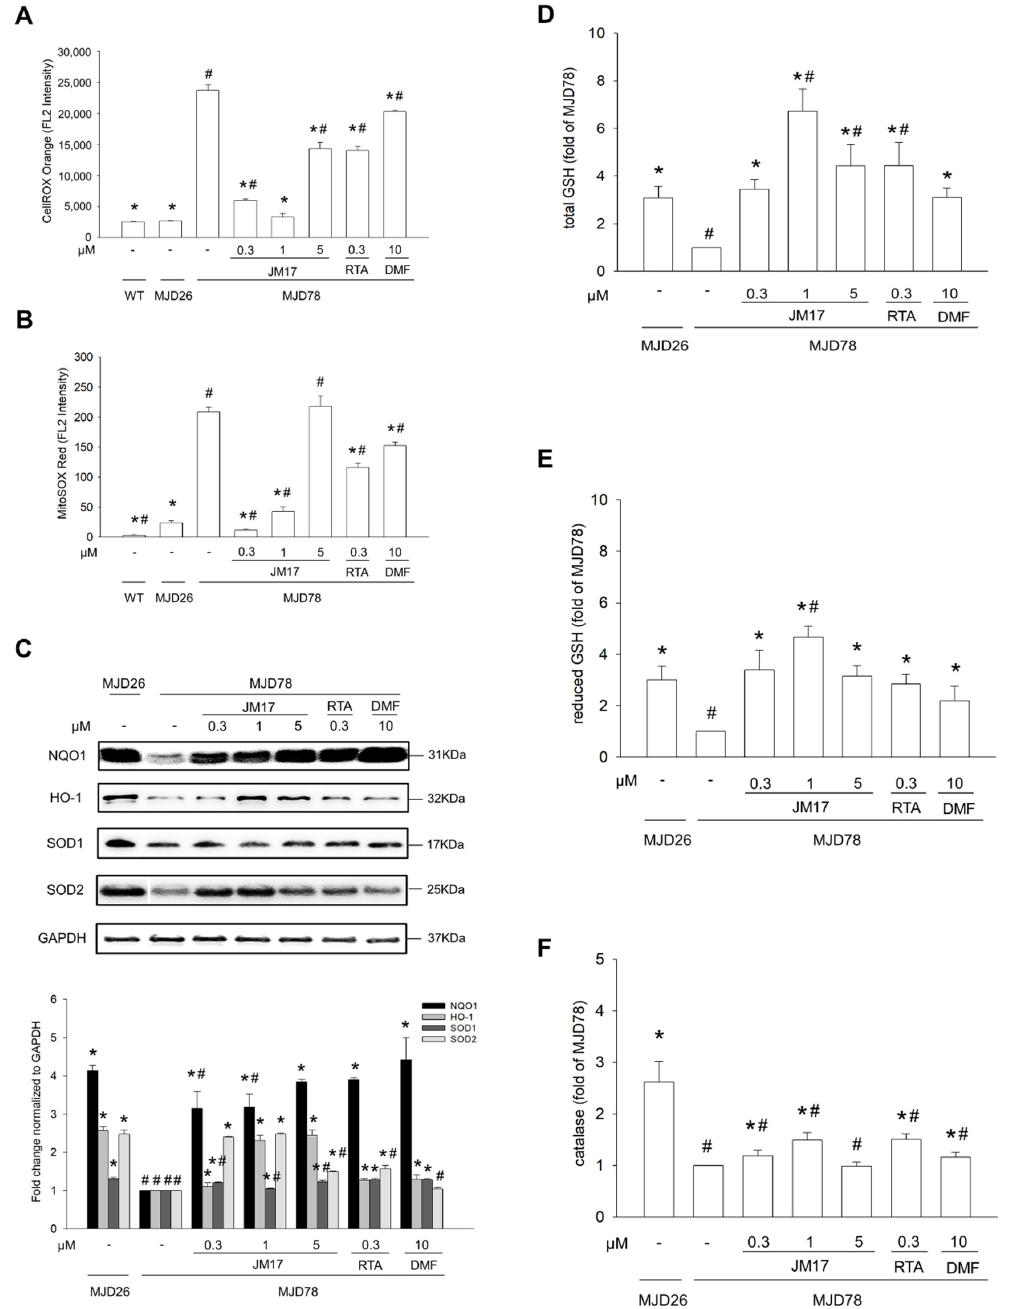
Figure 3. Reduction in oxidative stress including ROS formation and antioxidant enzyme activities. Cells were treated with or without DMSO vehicle or with 0.3, 1, or 5 μ M JM17, 0.3 μ M RTA-408, or 10 μ M DMF for 24 h. ( A ) Total and ( B ) mitochondrial ROS were measured with CellROX Orange and MitoSOX Red staining, respectively, and were quantified by flow cytometry. ( C ) Protein expression of NQO1, HO-1, SOD1, and SOD2. ( D ) Total GSH, ( E ) reduced GSH levels, and ( F ) catalase activity were measured with a GSH + GSSG/GSH assay kit and an AmpliteTM Fluorimetric Catalase assay kit, respectively, and were quantified using a FCLARIOstar Plate Reader. Data are presented as the mean ±SD of at least three independent experiments. Data are expressed as multiples of values in ( A , B ) graphs and values from the treated cells were normalized to those of the MJD78 cells treated with DMSO vehicle only in graphs ( C – F ). * p < 0.05, compared to non-treated MJD78 group; # p < 0.05, compared to MJD26 group.